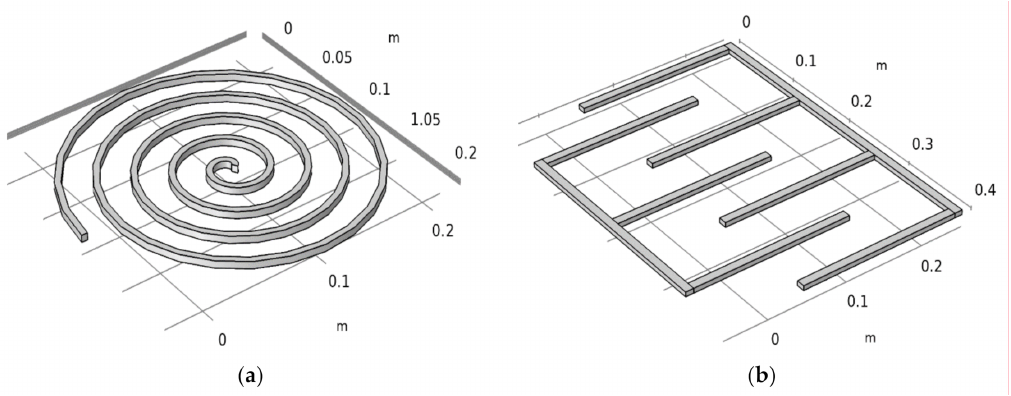
Figure 4. ( a ) Geometry of the flat coil; ( b ) geometry of the interdigital